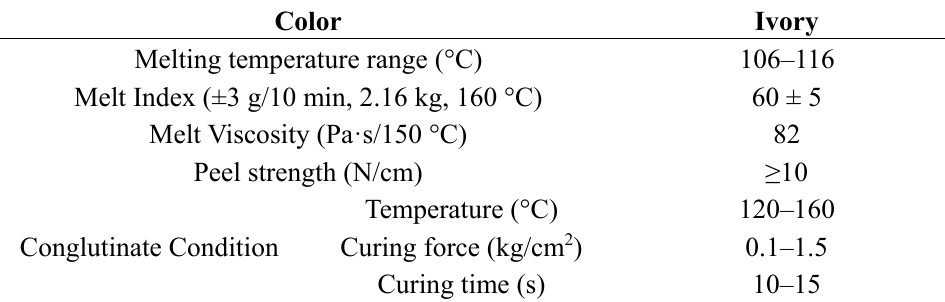
Table 1. Characteristics of hot-melt polyamide (HMP).